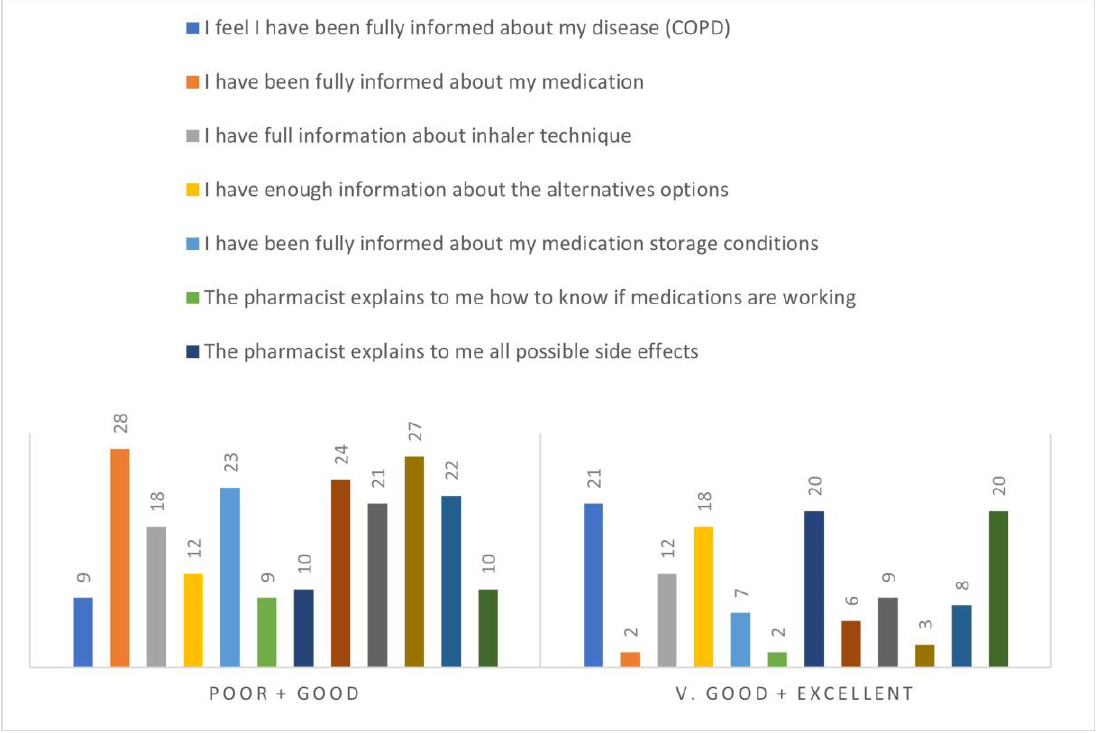
Fig. 2. Histogram showing the distribution of the participants according to the patient satisfaction with pharmaceutical care services